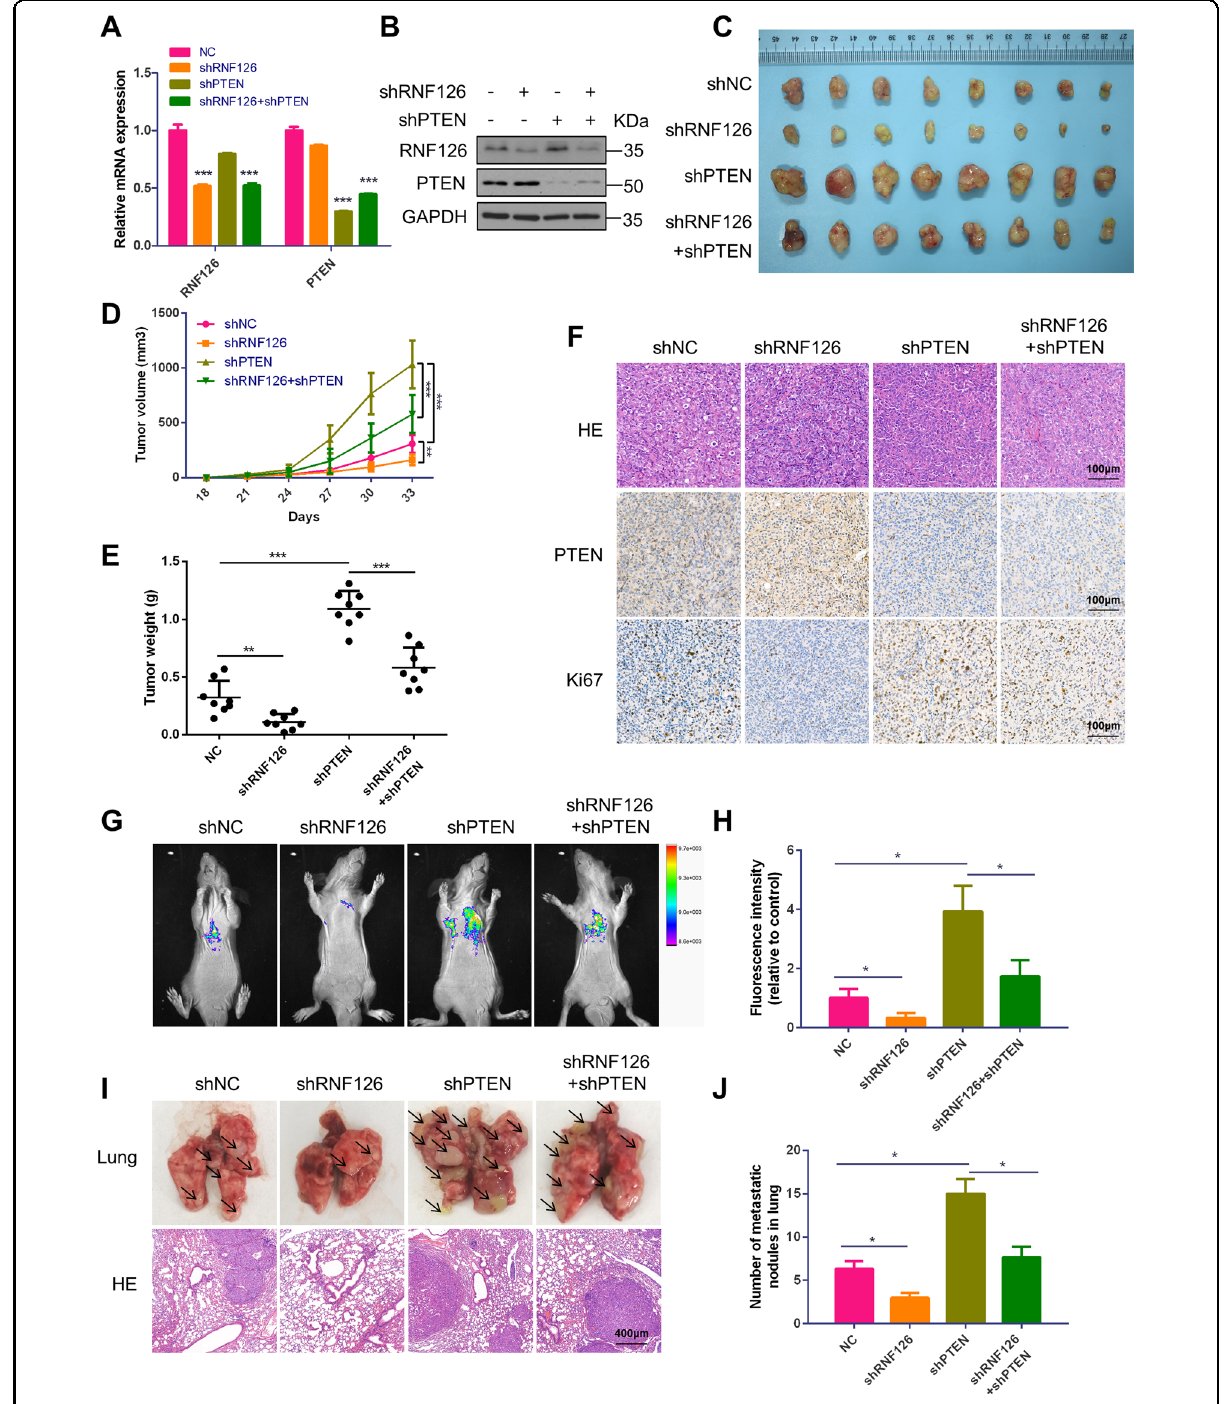
Fig. 7 Effects of RNF126 and PTEN on BCa cell progression in vivo. A , B The qRT-PCR and western blotting showed the stable knockdown of RNF126 and PTEN mRNA and protein levels in T24 cells. C LV-control, LV-shRNF126 , LV-shPTEN and LV-shRNF126 + shPTEN T24 cells were subcutaneously injected into four groups mice to generate the xenograft models. When the mice grew for 5 weeks, the xenografts were taken out and photographed ( n = 8). D Tumor volume growth of BCa cells was measured twice a week until it grew for 5 weeks. E After the mice were sacri fi ced, the tumor weight was measured. F IHC demonstrated the expression of RNF126, PTEN and Ki67 proteins in tumors. Scale bar = 100 μ m. G , H The mice ’ s tails were intravenous injected the LV-control, LV-shRNF126 , LV-shPTEN and LV-shRNF126 + shPTEN T24 cells to establish the pulmonary metastasis models ( n = 3). The BCa cell migration capacity was demonstrated by the fl uorescence of pulmonary metastases. I After injection for 8 weeks, the mice were sacri fi ced and the lungs were taken out. Then, the lungs were stained with HE. The arrows denote the tumors transferred to the lungs. Scale bar = 100 μ m. J The quanti fi cation of pulmonary metastases was determined by counting the metastatic nodules. *** p <0.001, ** p <0.01, * p